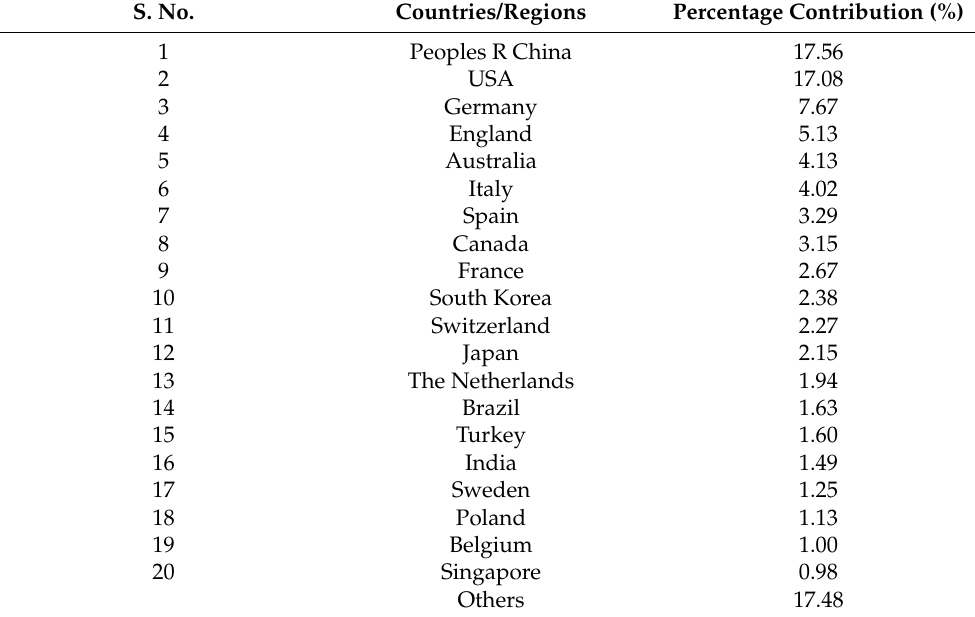
Table 2. Percentage contribution of various countries to research on prefab. S. No.